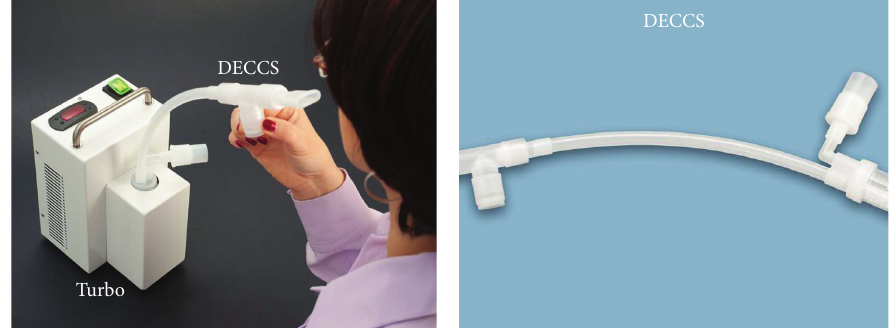
Figure 2: TurboDECCS device for exhaled breath condensate (EBC) collection (Medivac SRL, Italy). TurboDECCS consists of a portable Turbo Unit and a disposable DECCS collection system. DECCS is equipped with a mouthpiece, a one-way valve, a tube, and a collection cell inserted in a Peltier-type electrical cooling system (published with permission from Medivac SRL, Italy) .